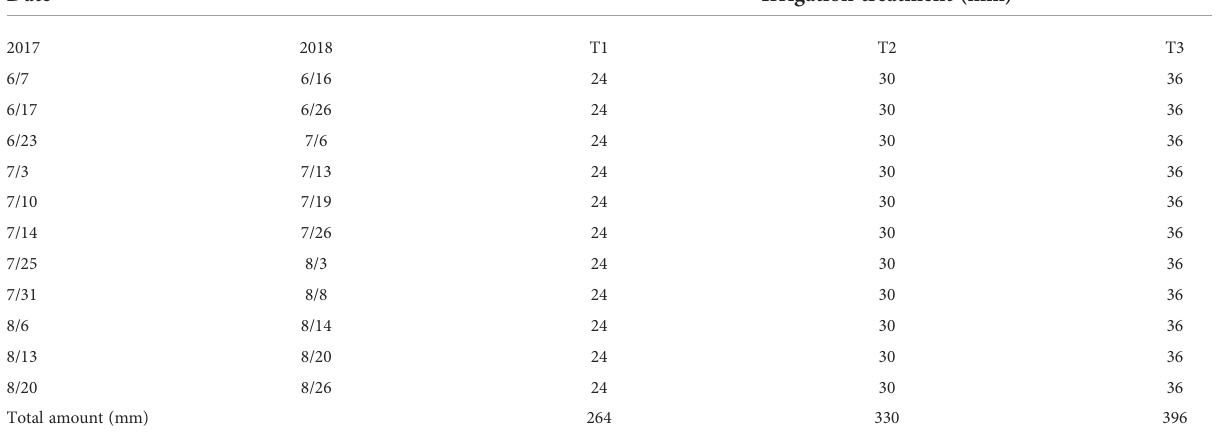
TABLE 1 Irrigation scheduling of cotton in 2017 and